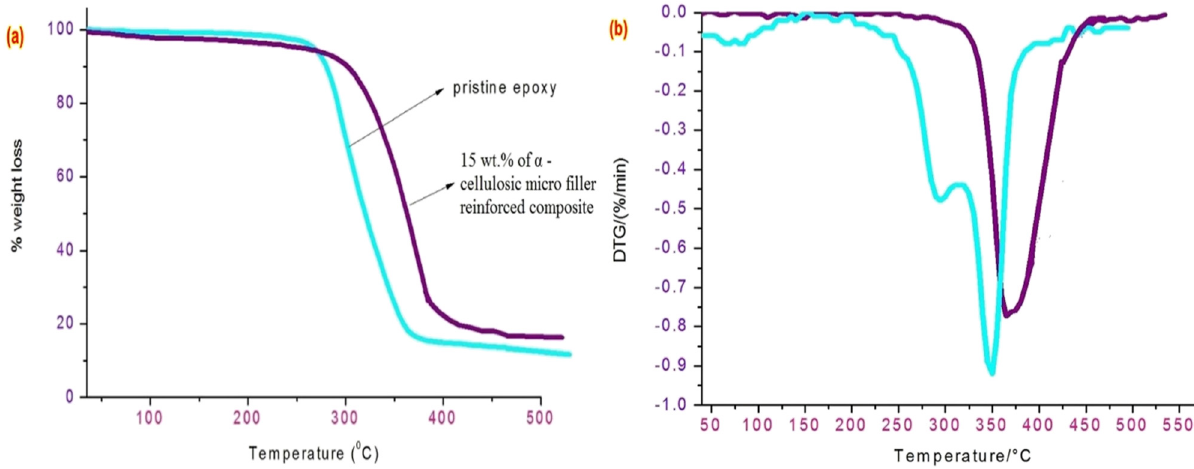
Figure 3: ( a ) TGA curve and ( b ) DTG curve of the 15 wt% of α - cellulosic micro - fi ller composite along with pristine epoxy ( 165 ) . Copyright ©2020,